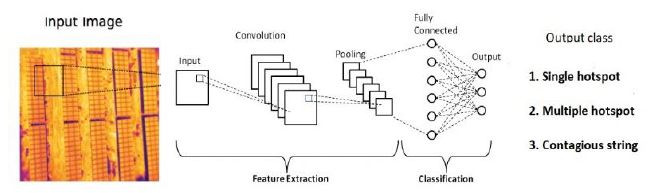
Figure 4. Deep CNN classification